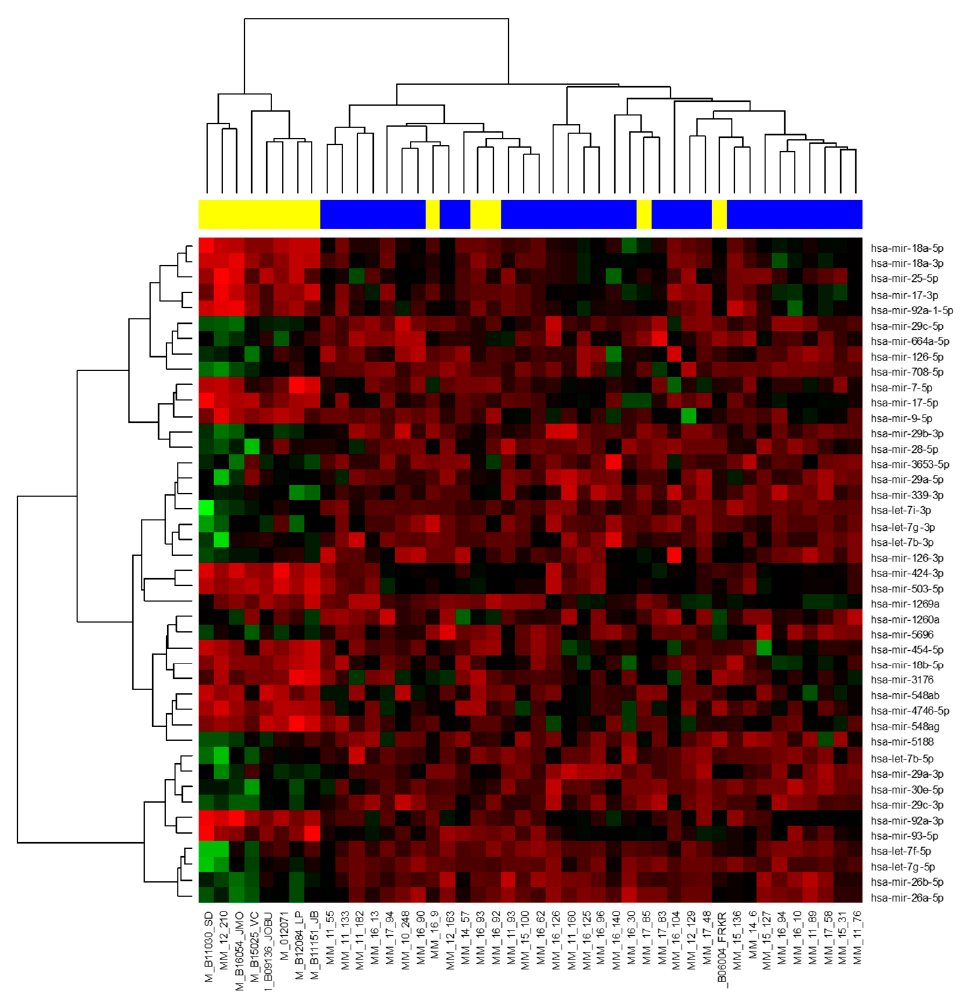
Figure 1. Heat map. A total of 43 miRNAs with significantly deregulated expression in patients with extramedullary disease (EMD, yellow) compared to multiple myeloma (MM) patients (blue) (adjusted p < 0.025). Table 2. List of ten most deregulated microRNAs (miRNAs) between the patients with extramedul- lary disease (EMD) and multiple myeloma (MM) patients identified during the exploration phase of the study by next-generation sequencing.